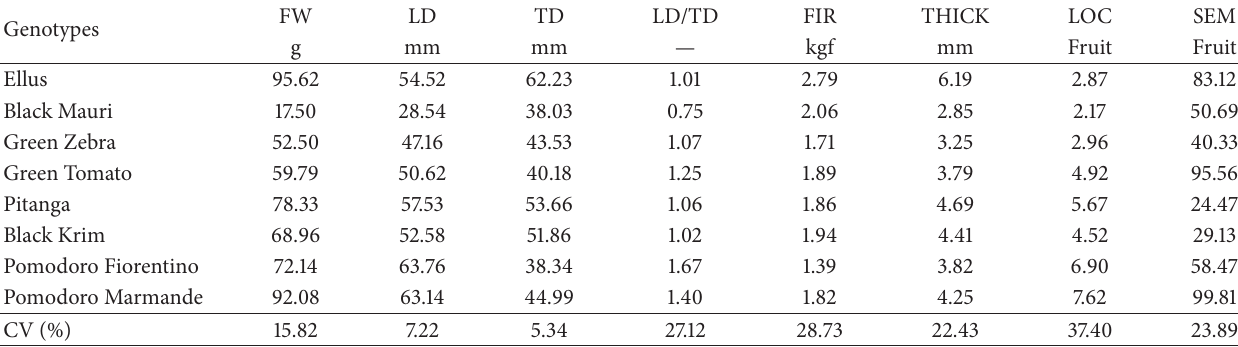
CV: coefficient of variation.